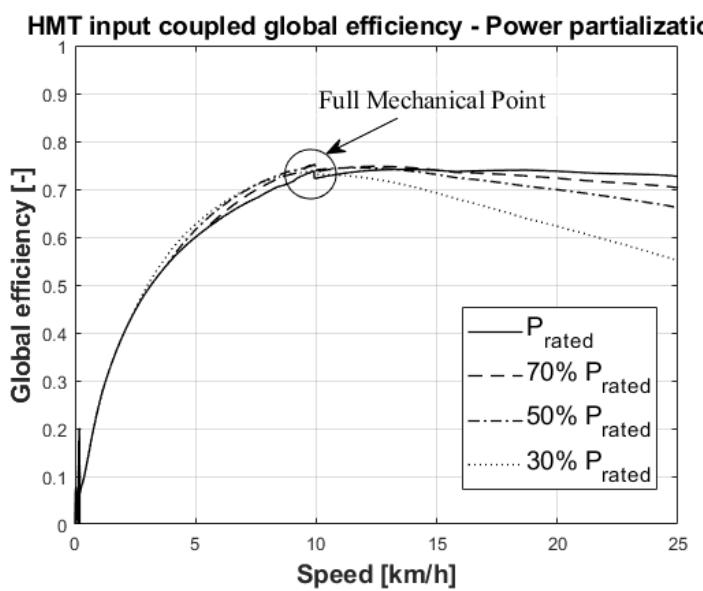
Figure 16. HMT global efficiency. Highlighted is the FMP at which the transmission reaches the best efficiency.